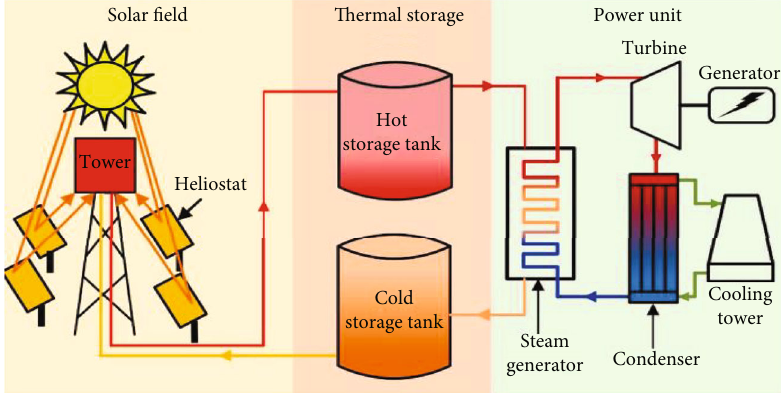
Figure 5: Schematic diagram of the solar tower system